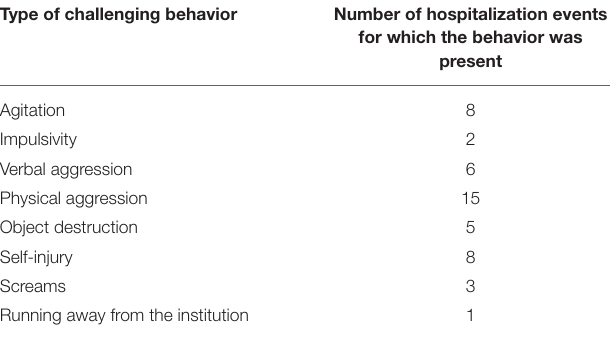
TABLE 2 | Types and prevalence of challenging behaviors in the study sample.